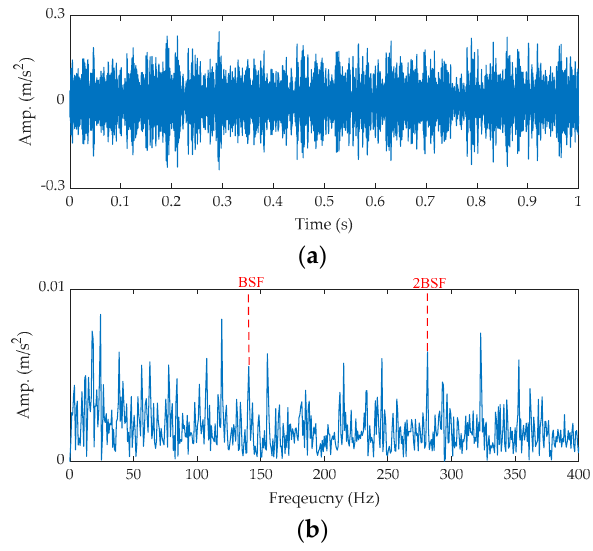
Figure 17. The results by the ICFGF for the ball fault signal: ( a ) filtered signal and ( b ) SES.